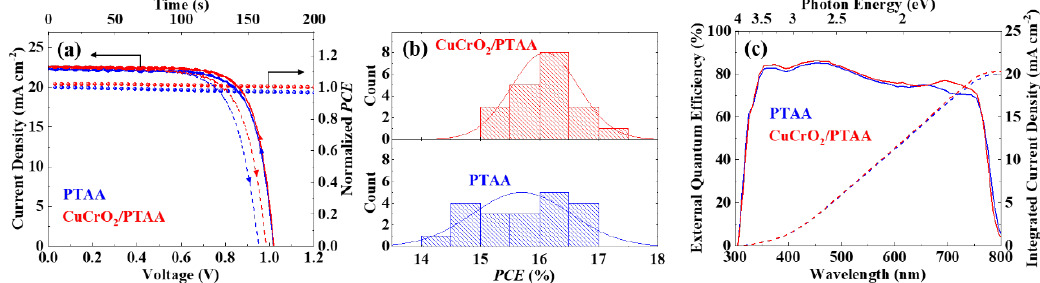
Figure 3. Trap density analyses of devices with di ff erent HTLs: ( a ) Dark J-V characteristics of hole-only devices with di ff erent upper HTLs, and calculated trap densities (N tTFL ) from trap-filled limited voltages (V TFL ); ( b ) Nyquist plot, ( c ) capacitance-frequency plot, and ( d ) trap density of states obtained from the capacitances (with the integrated trap density N tC ), in the device structure of ITO/SnO 2 /perovskite/HTL/Au.